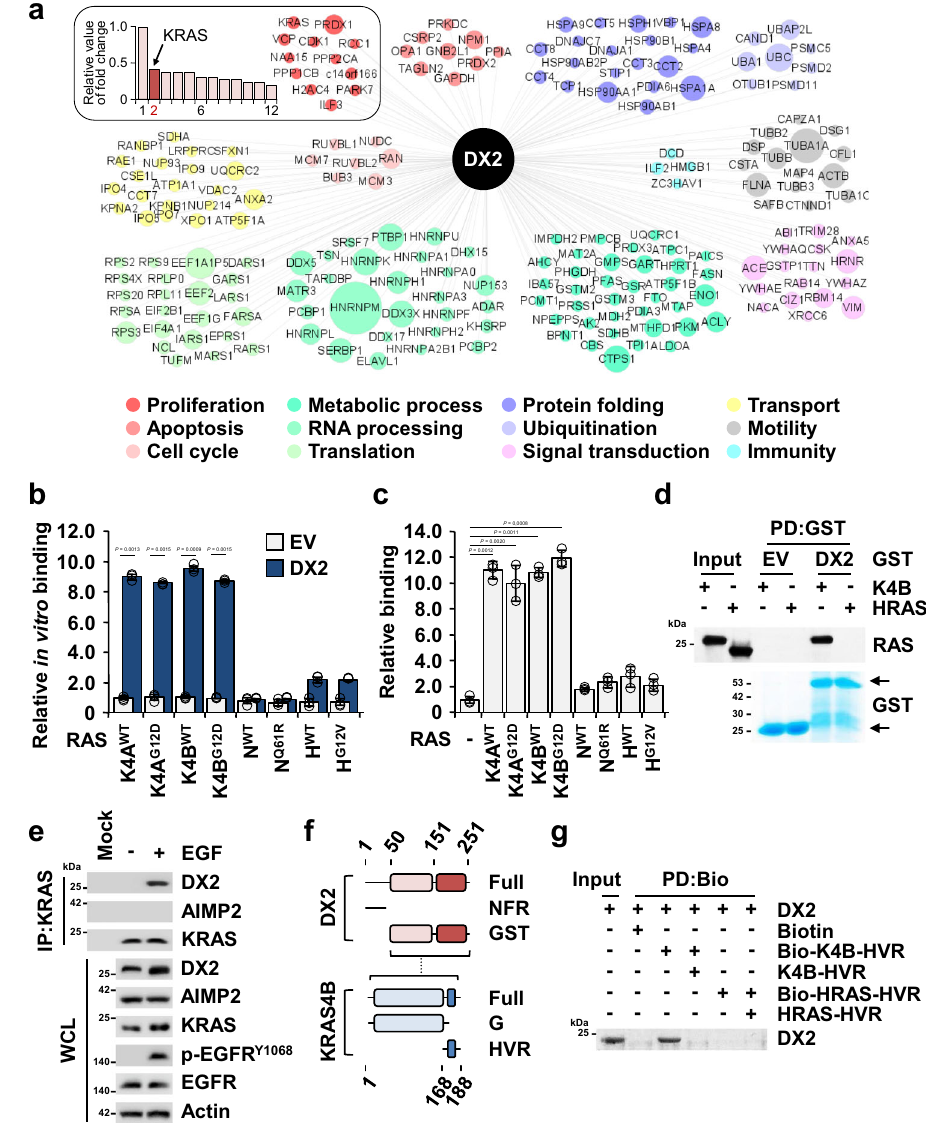
Fig. 2 Binding of DX2 to KRAS. a Top 200 proteins identi fi ed as the potential binding proteins of DX2 by LC-MS analysis. The relative fold change values of 12 proteins in proliferative ontology were represented as the bar graph (left upper box). Among 12 identi fi ed proteins, PRDX1 was detected at the highest fold change and the fold changes of other proteins were divided by that of PRDX1. The relative values of the other eleven proteins were graded, taking the value of PRDX1 as 1. Diameter of circles denotes the relative fold changes of a total of 200 identi fi ed proteins. b , c Determination of speci fi c binding of DX2 to KRAS. DX2 was mixed with different nanoluciferase-RAS isoforms. Amounts of the indicated RAS isoforms co-precipitated with DX2 were determined by luciferase activity and are shown as a bar graph ( b ). CCD18CO cells expressing Strep-tagged DX2 and the indicated nanoluciferase-RAS isoforms were precipitated using a strep-tactin column. Amounts of the indicated nanoluciferase-RAS isoforms co-precipitated with DX2 were measured and shown as above ( c ). All the experiments were independently repeated thrice and error bars denote S.D. Data are presented as mean values± S.D. P value is from the two-sided t test. d In vitro pull-down assay showing direct binding between DX2 and KRAS4B. Co-precipitated KRAS4B or HRAS with GST-DX2 was detected by SDS-PAGE and immunoblotting using an anti-pan RAS antibody. GST proteins were detected by Coomassie staining. Results are representative of at least three independent experiments. e Endogenous KRAS in DLD-1 cells treated with EGF for 30 min was precipitated with the anti- KRAS antibody. p-EGFR was used as a positive control for EGF signaling. Results are representative of at least three independent experiments. f Schematic diagram presenting the binding region between DX2 and KRAS4B. Binding region is depicted as a dashed line (Supplementary Fig. 4a). g In vitro pull-down assay showing direct interaction between DX2 protein and KRAS4B, but not with HRAS, HVR peptide. Biotin-conjugated and native peptide were serially mixed with DX2 proteins for checking the binding speci fi city. Results are representative of at least three independent experiments. EV, PD, IP, and WCL represent empty vector, pull-down, immunoprecipitation, and whole cell lysate, respectively. Source data are provided as a Source data fi decreased during 500 ns and remained stable in the last 100 ns the two interfaces of the DX2-KRAS4B complex are critical (Supplementary Fig. 5i, j). To compare the binding mode of DX2 binding spots (Fig. 3c and Supplementary Fig. 5h). The distances to KRAS4B with or without GTP, KRAS4B structure from the of the key residue pairs (Supplementary Table 3) obtained from representative snapshot at 533.7 ns was also superimposed with the representative snapshot were calculated for the entire the initial structure for GTP-bound conformation. The difference simulation time. We observed that most of the distances gradually